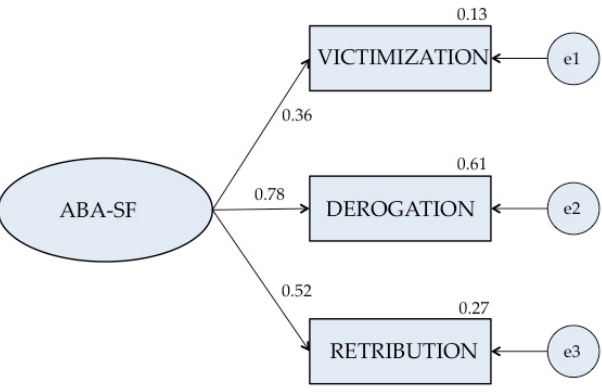
Figure 1. Standardized solution of the confirmatory factorial analysis, ABA-SF in adolescents.